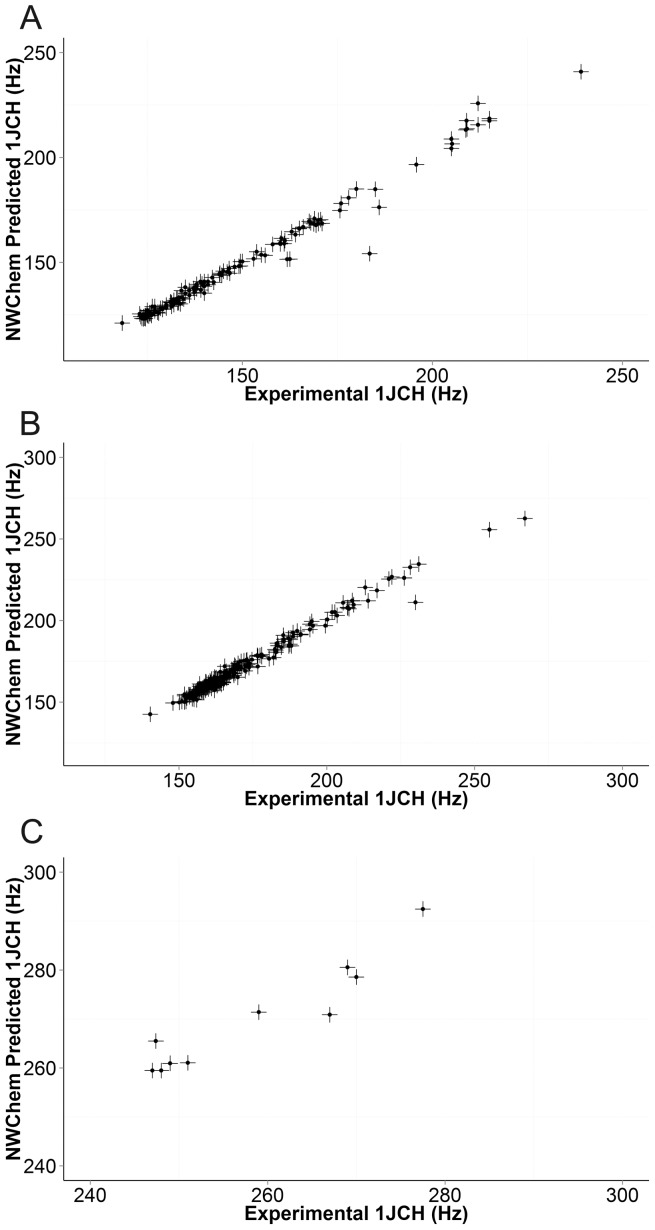
Plots of the observed and predicted 1JCH for different hybridization states.A: sp3 pairs. B: sp2 pairs. C: sp pairs.